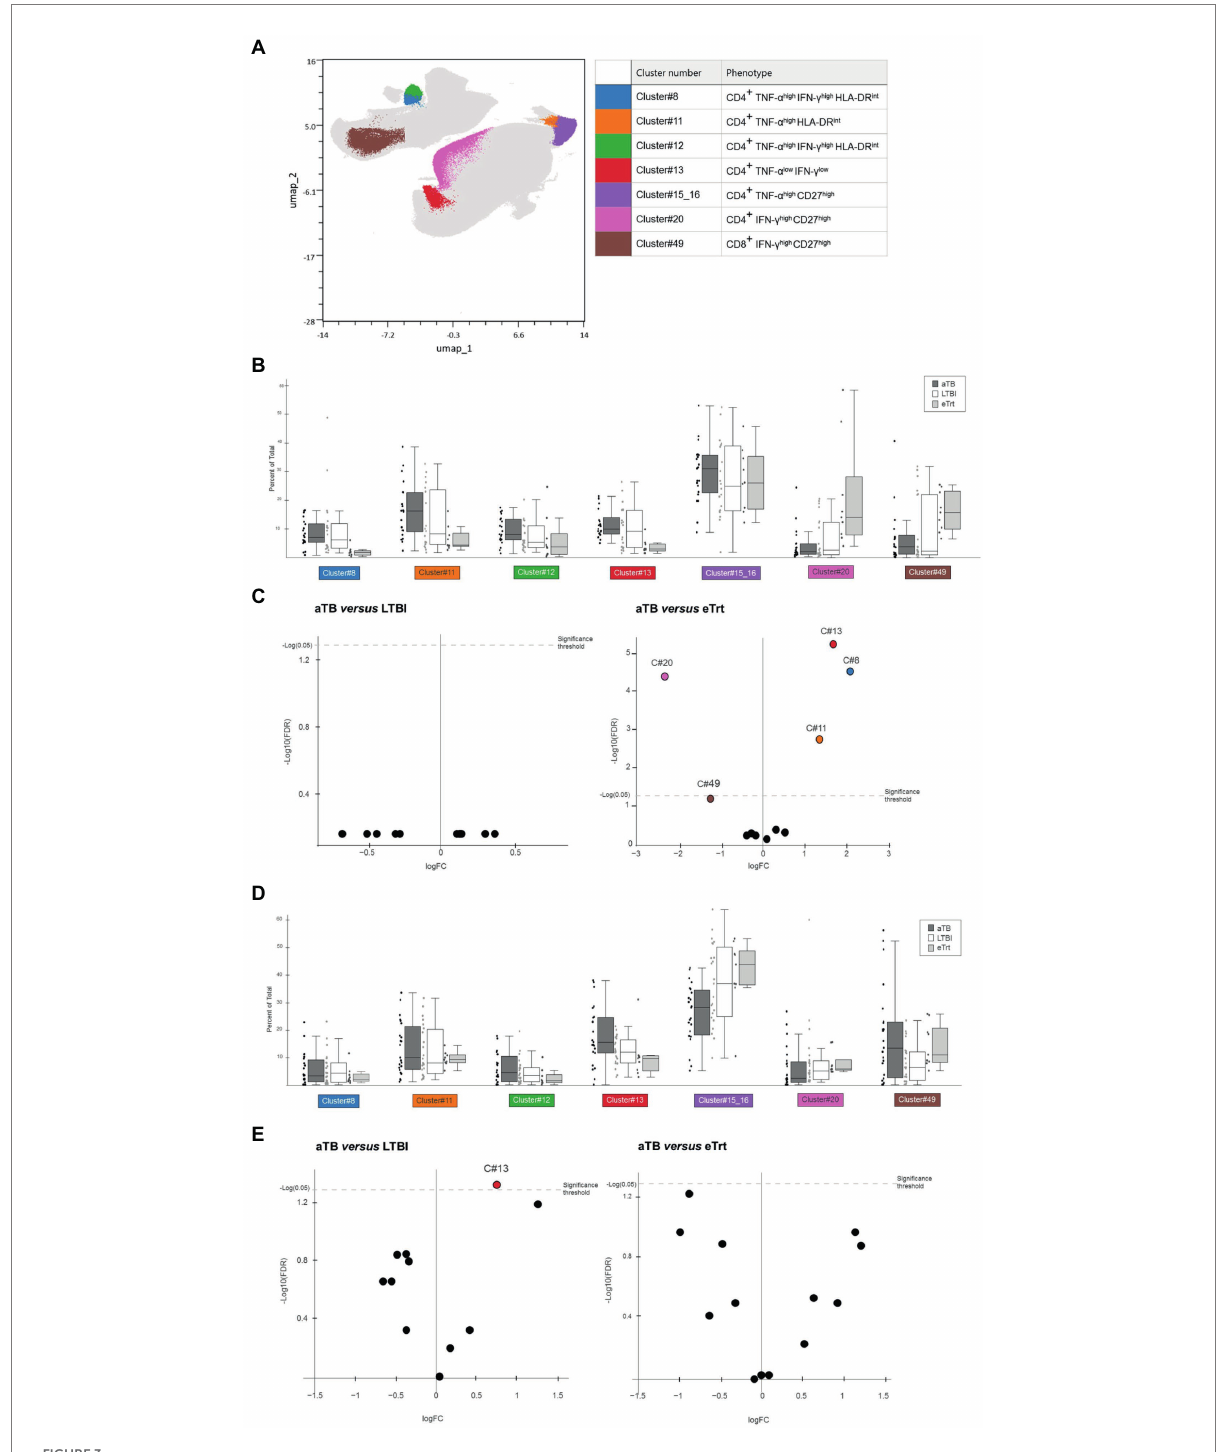
FIGURE 3 Results from multiparametric analyses of the samples. (A) UMAP based on the expression of CD4, CD8, TNF- α , IFN- γ , CD27, CD38, HLA-DR and Ki-67 markers in CD3 + cells from our dataset containing LTBI individuals and aTB patients before and after treatment, after stimulation with ESAT-6/CFP-10 or PPD. Colored clusters indicate populations with difference in abundance depending on disease status, obtained with FlowSOM and analyzed within TNF- α + and/or IFN- γ + subsets. In background, all 50 cell clusters defined. (B,D) Box and dot plots showing percentage (Y axis) of each cluster of interest in each respective group [ (B) for samples after PPD stimulation, (D) for samples after ESAT-6/CFP-10 stimulation. Data plotted with median and interquartile range. (C,E) Volcano plot displaying logarithm scale of fold-change of percentage ratio of sample from aTB patients over LTBI individuals (left) and patients who completed treatment (right; C ) for samples after PPD stimulation, (E) for samples after ESAT-6/CFP-10 stimulation]. Positive values (logFC>1) show clusters whose proportion is increased in aTB, while negative values (logFC< − 1) show clusters whose proportion is decreased in aTB. Significant samples are represented above the threshold ( q < 0.05). Volcano plots were automatically produced by the OMIQ software. aTB, active TB; LTBI, latent tuberculosis infection; eTrt, aTB patients after anti-TB treatment, UMAP: uniform manifold approximation; FDR: false discovery